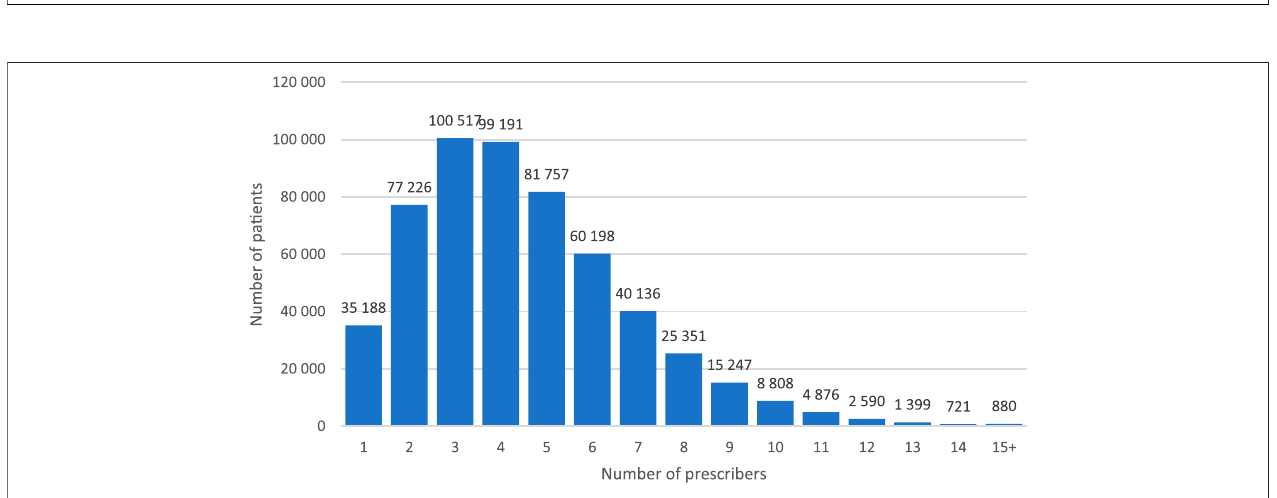
FIGURE 3 | Number of elderly patients on chronic polypharmacy in Poland in 2018 by Voivodeship (A) , and per 1,000 inhabitants of Voivodeship (B) .